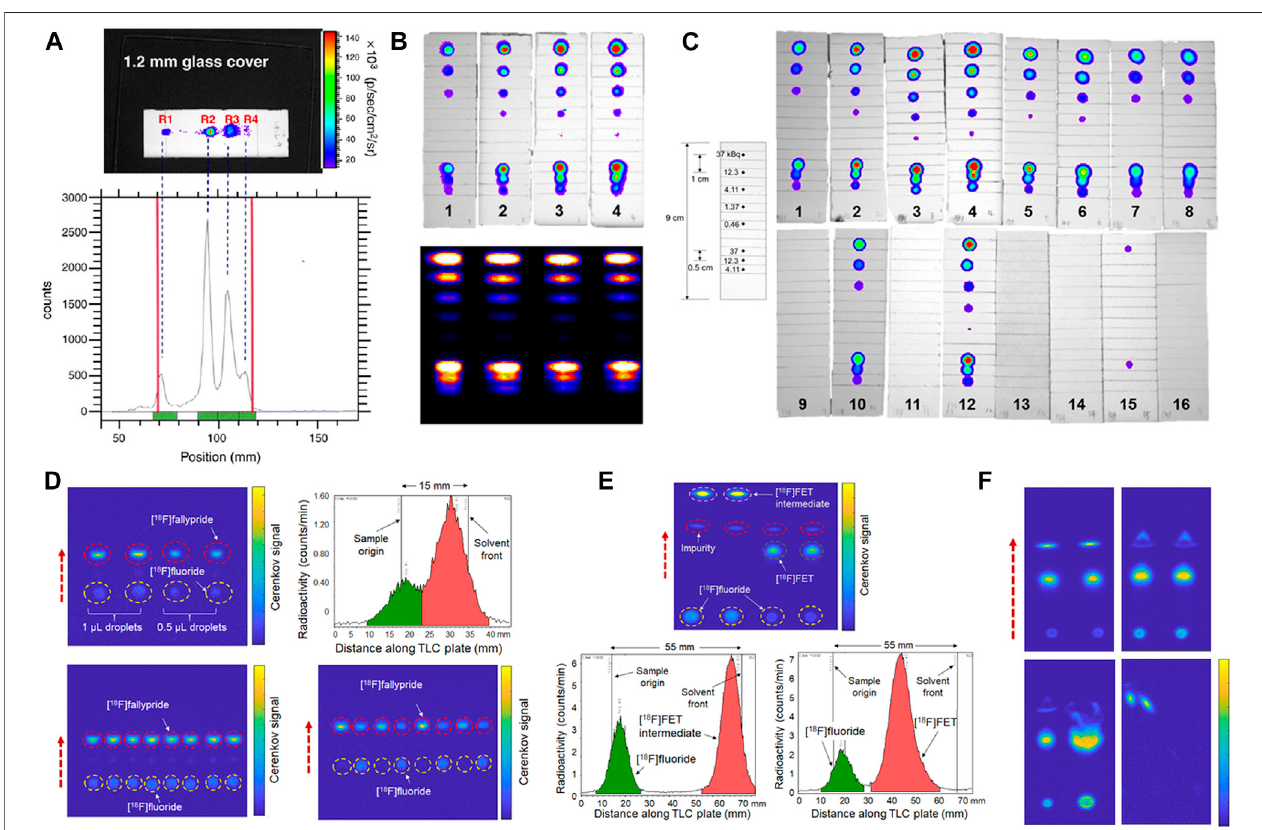
FIGURE 2 | Use of Cerenkov imaging in the analysis of radiopharmaceuticals via radio-TLC. (A) Cerenkov image of TLC plate showing separation of multiple 131 I-containing compounds (top) , and corresponding pro fi le from a radio-TLC scanner (bottom) . Reproduced from [47], © 2011, with permission from Elsevier. (B) Cerenkov image of spots of iodine-131 on different types of TLC plates (top) and corresponding output from a 2D radio-TLC scanner (bottom) . (C) Simultaneous imaging of 16 different types of TLC plates spotted multiple times each with iodine-131. The inset diagram (left) indicates the deposited amounts and spacing. (B,C) reproducedwithpermission from[48], © 2018,AmericanChemicalSociety. (D) Cerenkovimage ofonemulti-laneTLCplatecontainingfoursamplesofcrude[ 18 F] Fallypride spotted at different volumes and subject to only 15 mm separation (top left) and corresponding output of radio-TLC scanner of one representative lane cut from themulti-laneTLCplate (topright) .Cerenkovimagesofplatescontaining8samplesseparatedsimultaneously (bottom twoimages) . (E) Cerenkovimage ofone multi-laneTLCplate after 35 mm separation oftheintermediate fl uorination product and fi nalproductafter deprotection (n (cid:1) 2each) inthesynthesisof[ 18 F]FET.Bottom graphs show corresponding output from radio-TLC scanner for one representative lane from each sample cut from the multi-lane TLC plate. (F) Illustration of qualitative value of Cerenkov imaging. Normal development process (top left); development after incomplete sample drying (top right); development with suitable and excessive sample volume (bottom left); and development when liquid contamination occurred on right side of plate during separation (bottom right). ( D – F) adapted from [49], © 2020, with permission from Elsevier.